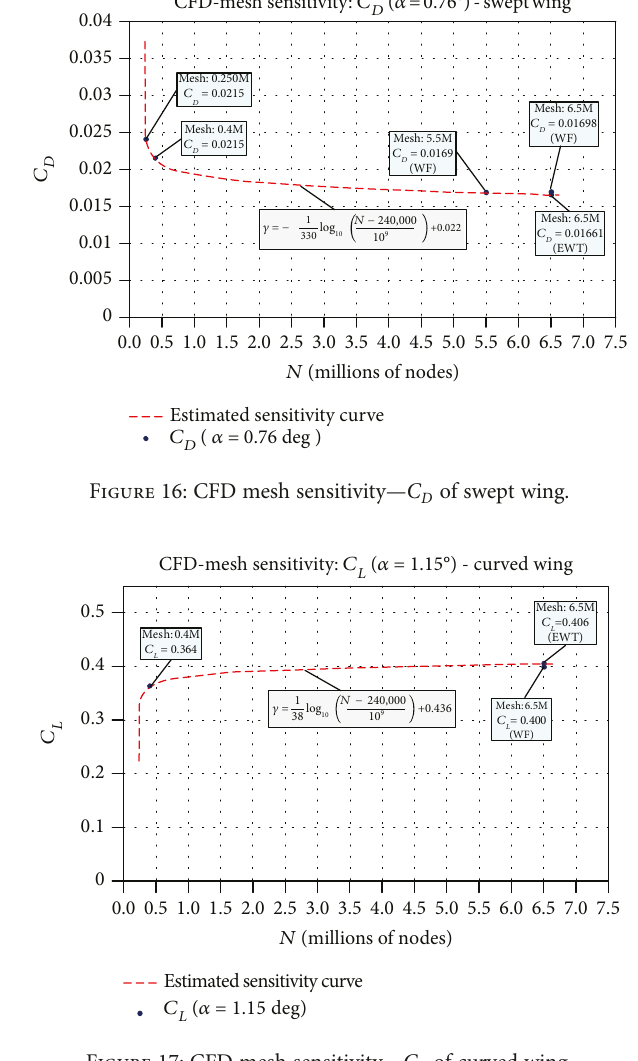
L of curved wing.